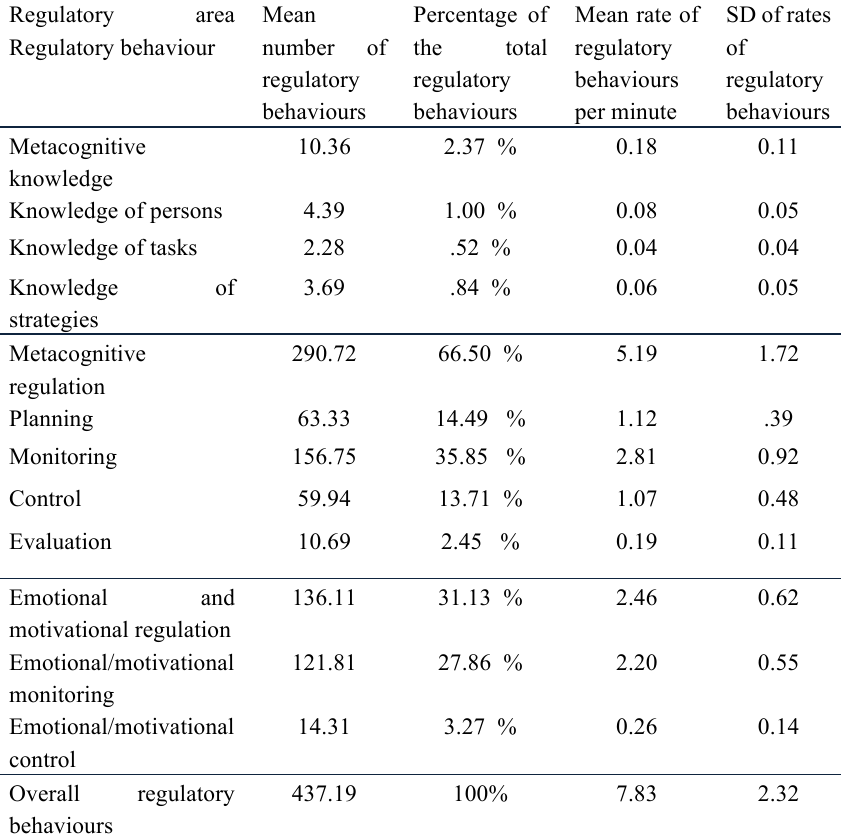
Distribution of children’s regulatory behaviours during musical play to areas of regulatory behaviour and specific regulatory behaviours